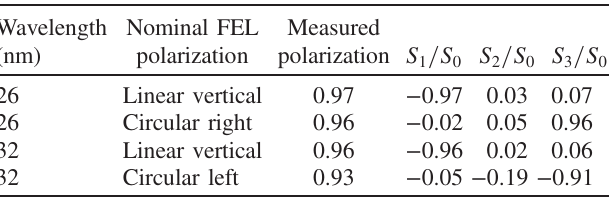
TABLE V. Results of the analysis of the VUV-optical polar- imeter data. Total degree of polarization and Stokes parameters, normalized to S 0 , are reported for different undulator settings and wavelengths.